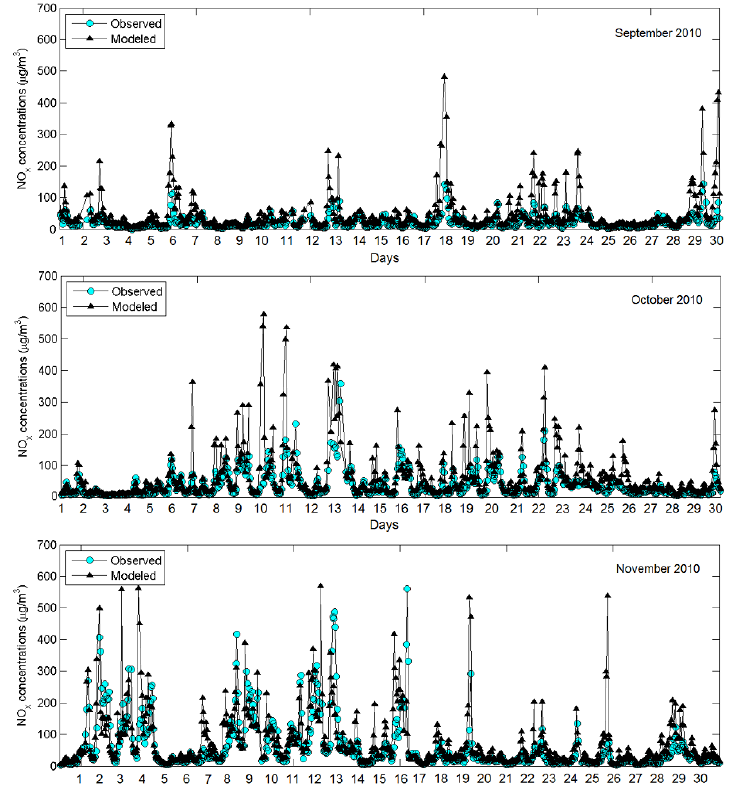
Figure 5. Model to monitor comparison: time series of hourly NO site 26-163-0019 (E. 7 Mile Road) for three-month period September-November